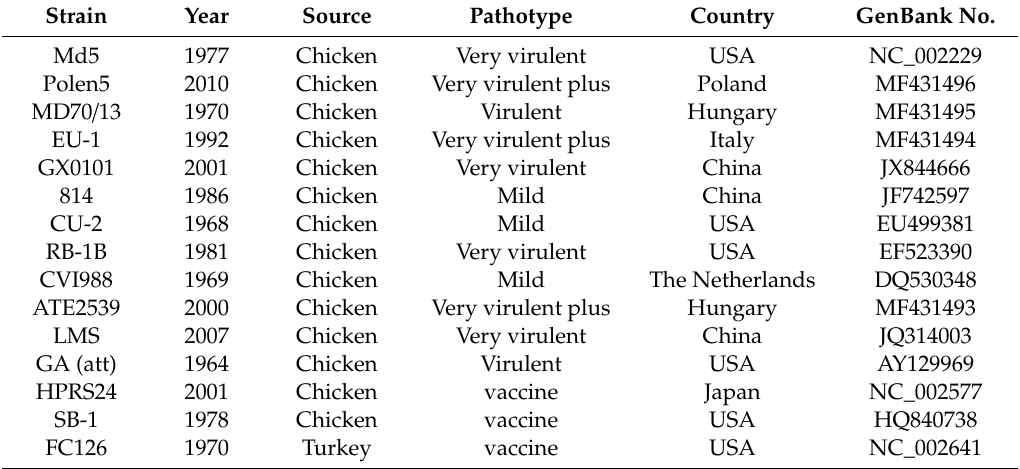
Table 3. Reference Marek’s disease virus (MDV) strains used for the phylogenetic analysis. Strain Year Source Pathotype